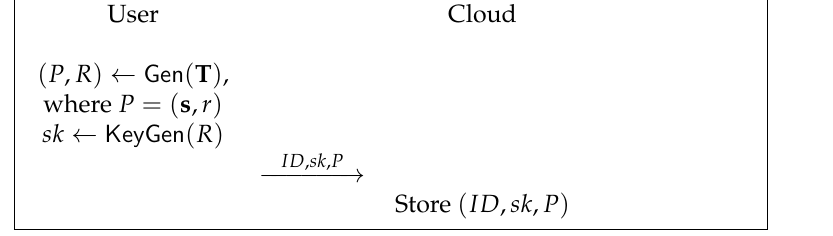
Figure 2. Device registration.